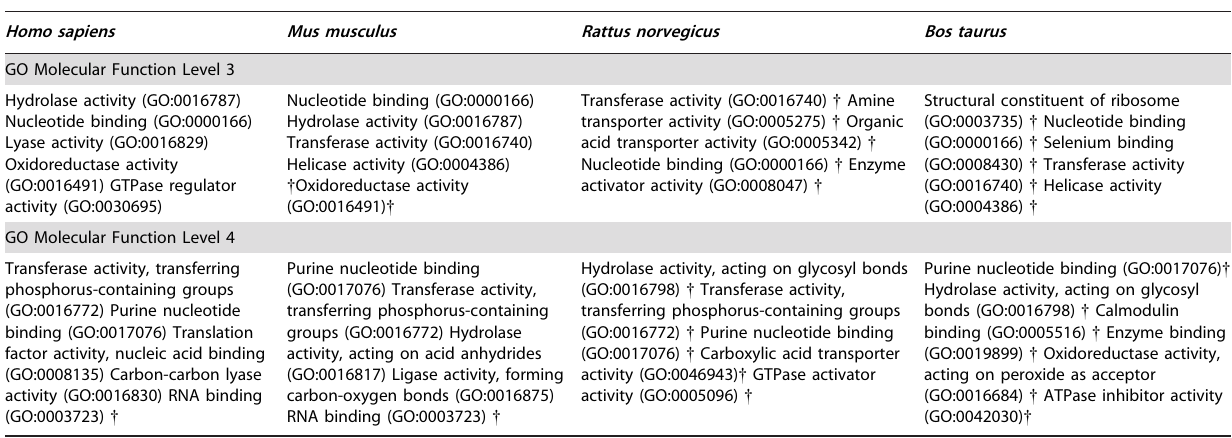
Table 6. Most represented GO terms per